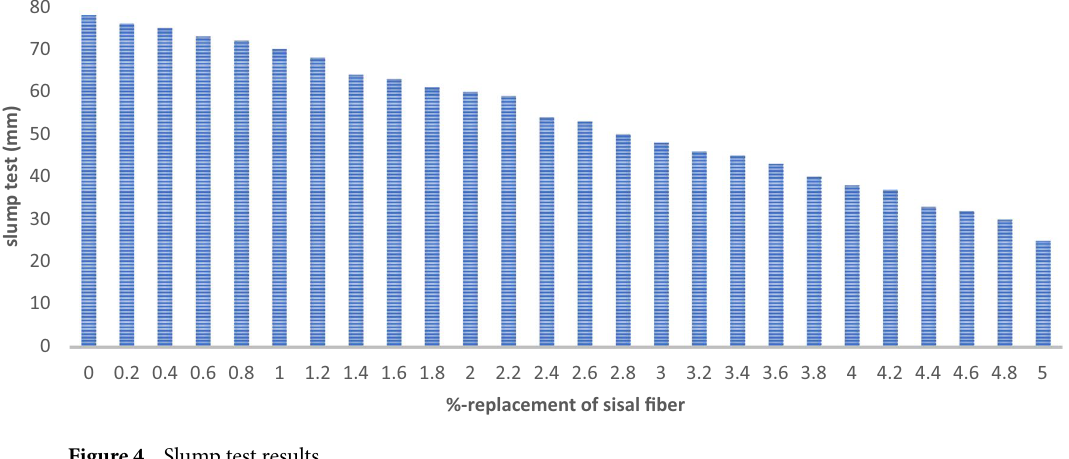
Figure 4. Slump test